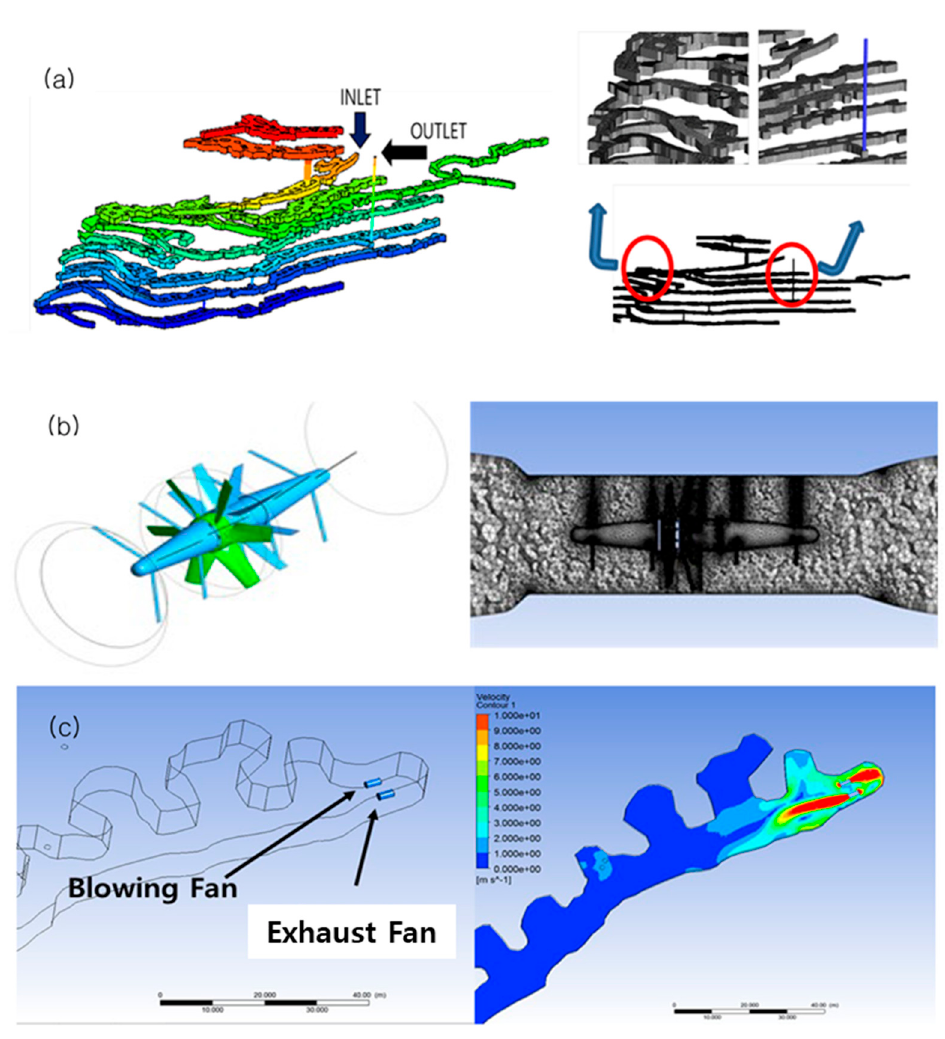
Figure 3. Applications of CFD to mining engineering ( a ) airflow analysis in entire mines ( b ) geometry and grid of a fan used in mine tunnels ( c ) parametric study of optimal locations of two fans near mining faces.